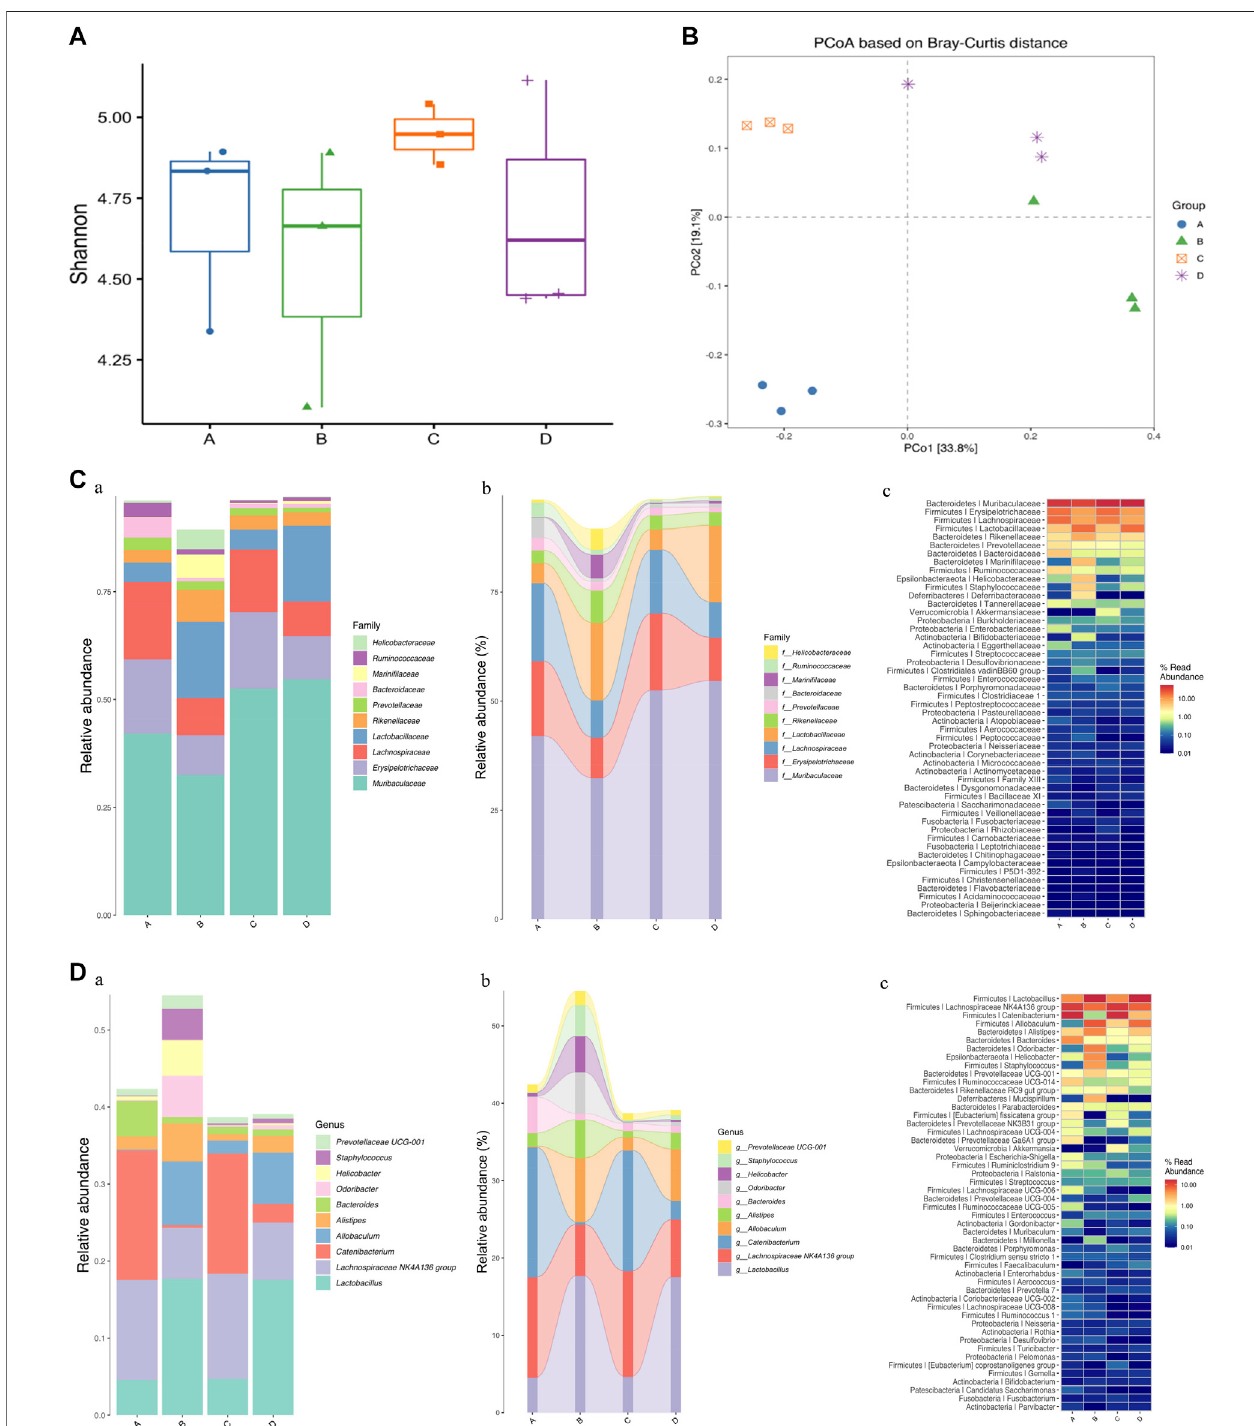
FIGURE 5 | Effects of OPA on gut microbiota in MPTP-induced PD model mice. (A) analysis of alpha diversity based on 16S rRNA sequencing-predicted gut microbiota abundance by the Shnnon index; (B) PCoA based on Bray-Curtis of gut microbiota where samples of mice from different groups were highlighted with different colors. Principal components (PCs) 1 and 2 explained 33.8% and 19.1% of the variance, respectively. The position and distance of data points indicated the degree ofsimilarity in termsofboth the presence and relative abundance ofbacterial taxonomies; Analysesofrelative abundancein gutmicrobiota at the (C) family and (D) genus level among different groups, based on 16S rRNA sequencing ( n = 3, mean ± SD). (a) Barplot; (b) Sankeyplot; (c) Heatmap; in above statistic graphs, A represented the control group injected with saline; B represented 0 mg/kg group injected with MPTP; C represented low-dose group injected with 100 mg/kg OPA; D represented high-dose group injected with 400 mg/kg